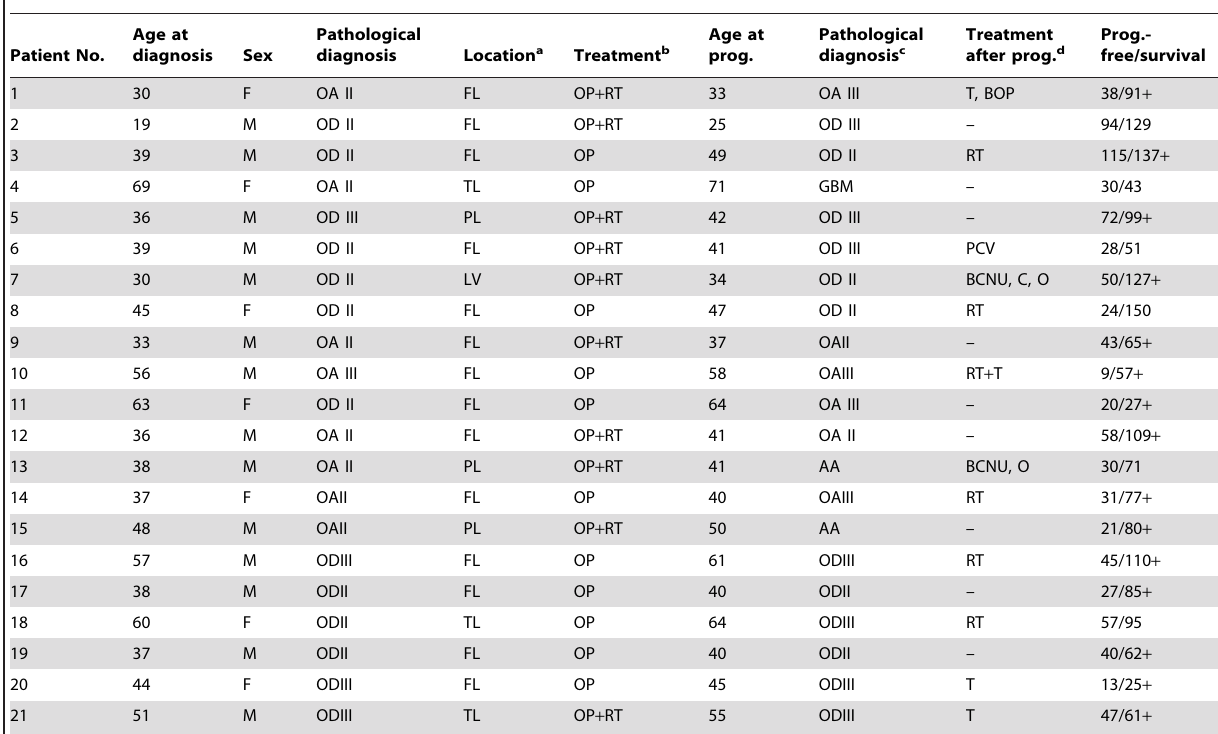
Table 2. Clinical characteristics, treatment, and outcome of patients.